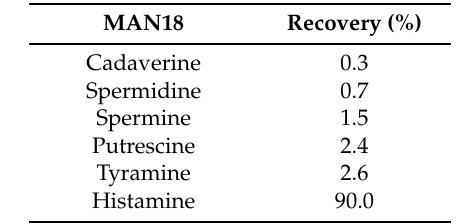
Table 1. The recoveries of chosen biogenic amines (spermine, spermidine, tyramine, putrescine, cadaverine,